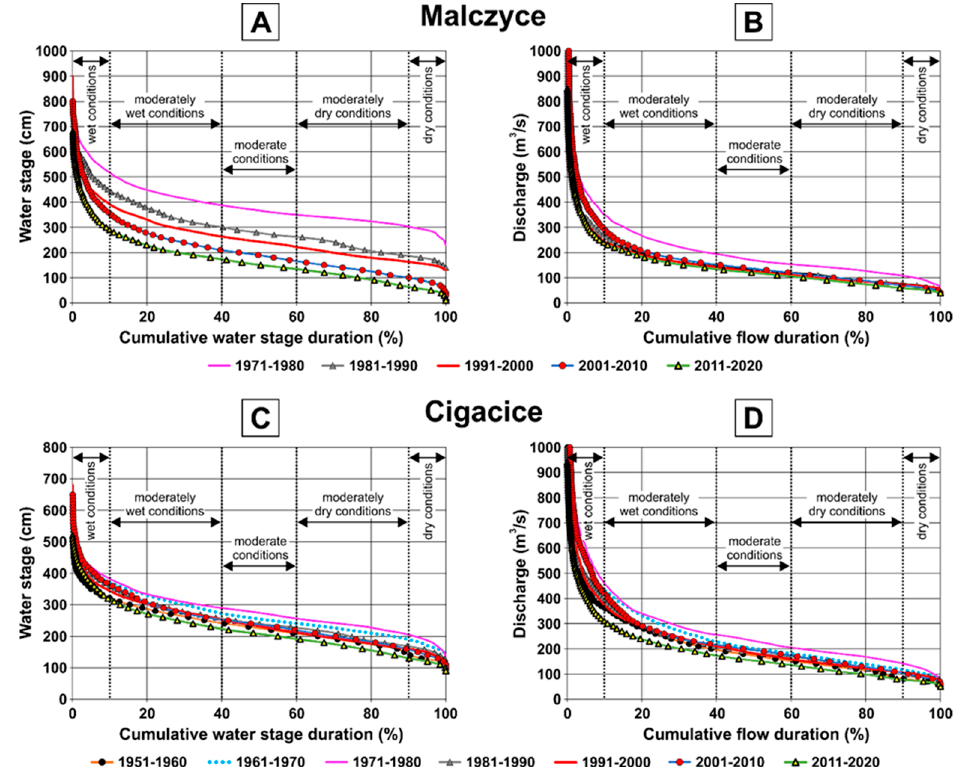
Figure 4. Water–stage ( A , C ) and discharge ( B , D ) duration curves for the Malczyce ( A , B ) and Cigacice ( C , D ) water–gauge stations from Section 3 of the Odra River. Note that the DD curves do not comprise the highest discharges (maximum discharges recorded at the Malczyce and Cigacice stations were 3020 and 2970 m 3 s − 1 , respectively), and thus discharges in the right panels do not correspond to water stages in the left